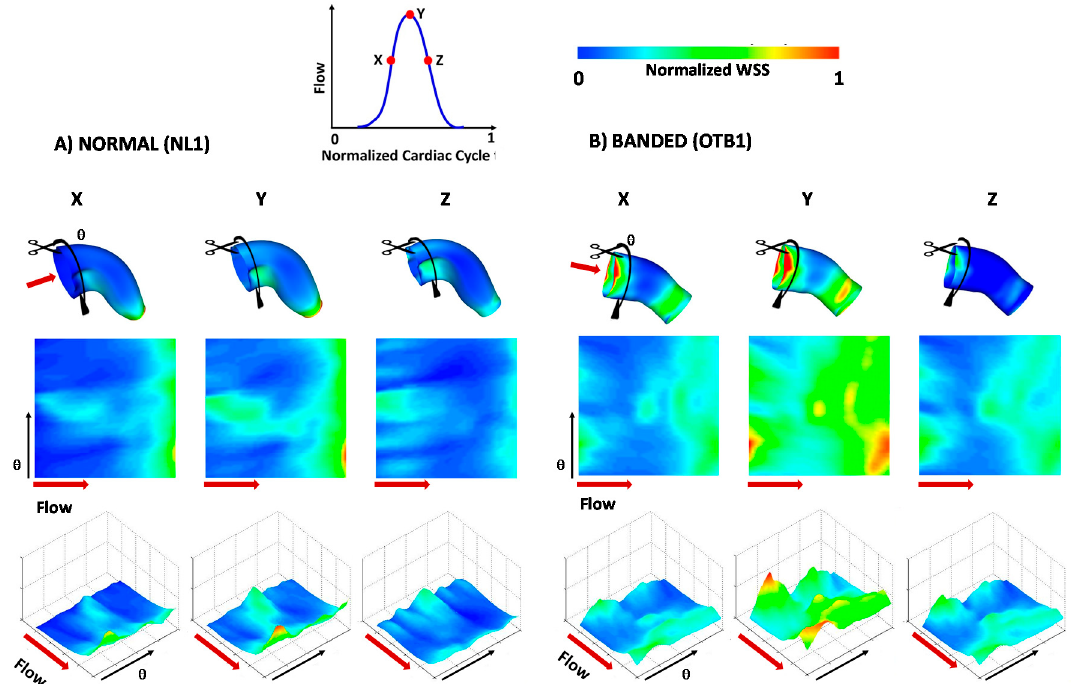
Figure 7. Normalized wall shear stresses (WSS) on the OFT endocardium computed from CFD simulations. The WSS are depicted at three times during the cardiac cycle, for representative ( A ) normal (NL1); and ( B ) banded (OTB1) embryos. To avoid WSS inaccuracies due to boundary effects in the CFD computations, results are shown for the central portion of our OFT models, excluding about 50 µm of the OFT from the inlet and outlet portions. To better visualize the heterogeneity of WSS over the endocardium, we show normalized WSS over three rows of plots. Top row: 3D endocardium surface with WSS color coded on the surface. Middle row: 3D WSS values were mapped to a square section, as if the endocardium was cut as shown in the top 3D picture, and WSS values displayed flat on a plane. Flow direction, from OFT inlet to outlet is shown by a red arrow, and the direction along the OFT circumference ( θ ) depicted by a black arrow. Bottom row: Depicts WSS as in the middle row, but in addition to color coding the WSS, WSS values are shown by elevation as well, to help visualizing the WSS distribution. WSSs were normalized to the maximum WSS in the normal embryo, which occurred at the OFT outlet region during maximum flow.